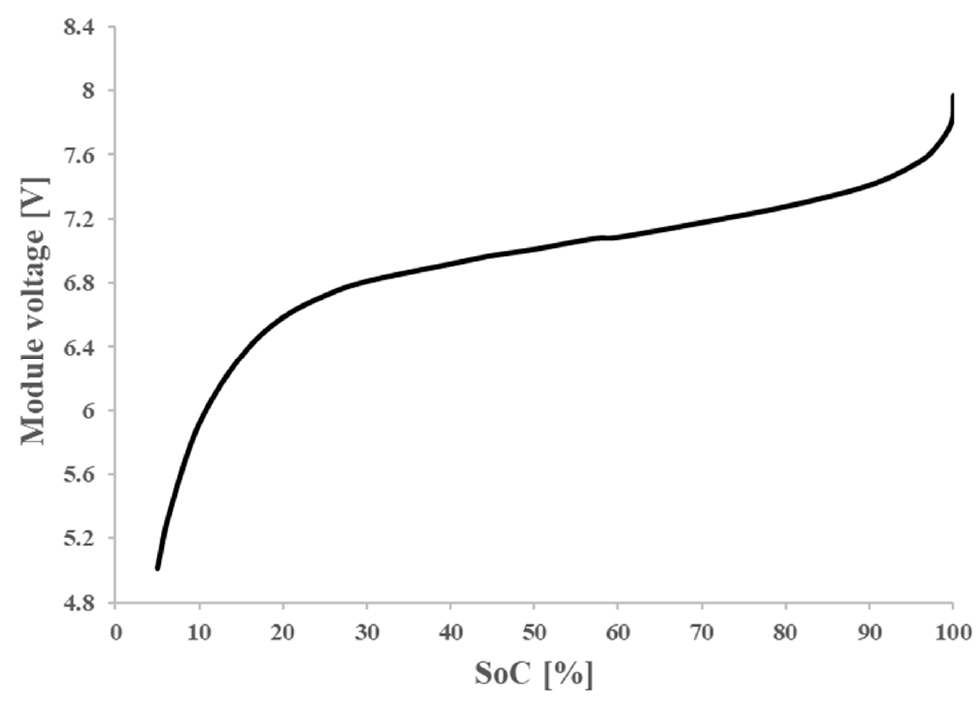
Figure 7. Nissan leaf second life battery voltage variations in various SoCs [22,29–31].